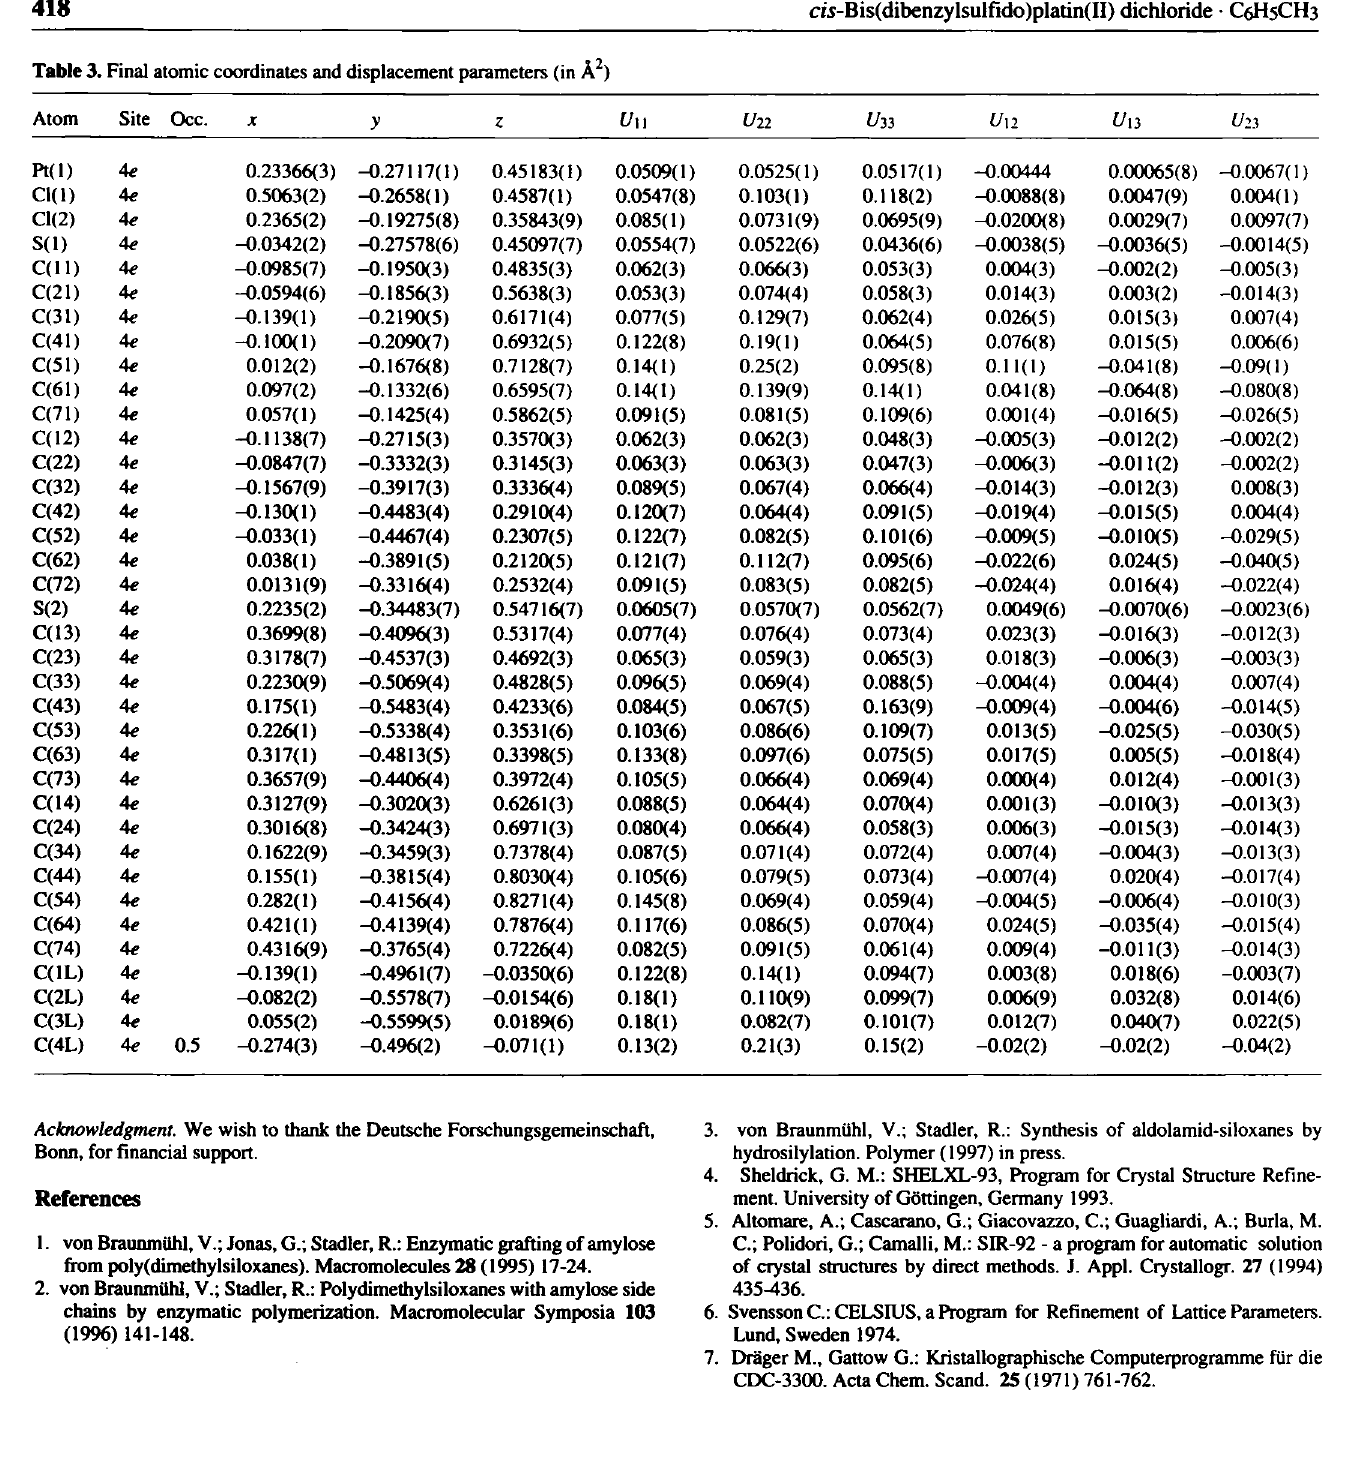
Table 3. Final atomic coordinates and displacement parameters (in A^) Atom Site